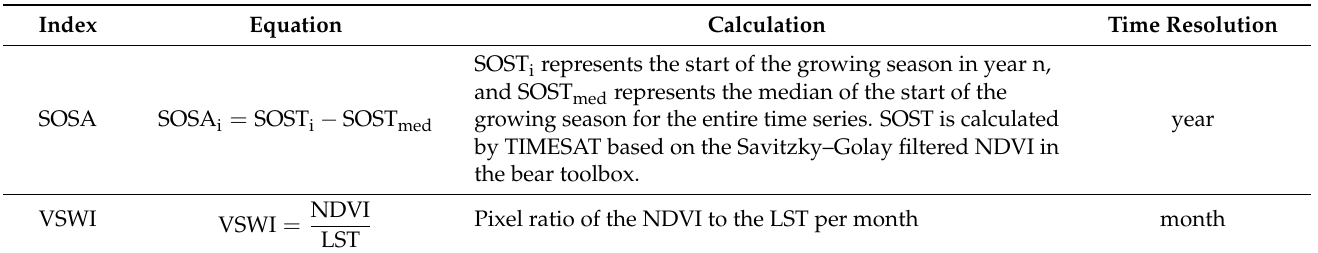
Table 3. Calculation methods for the start of season anomaly (SOSA) and the vegetation supply water index